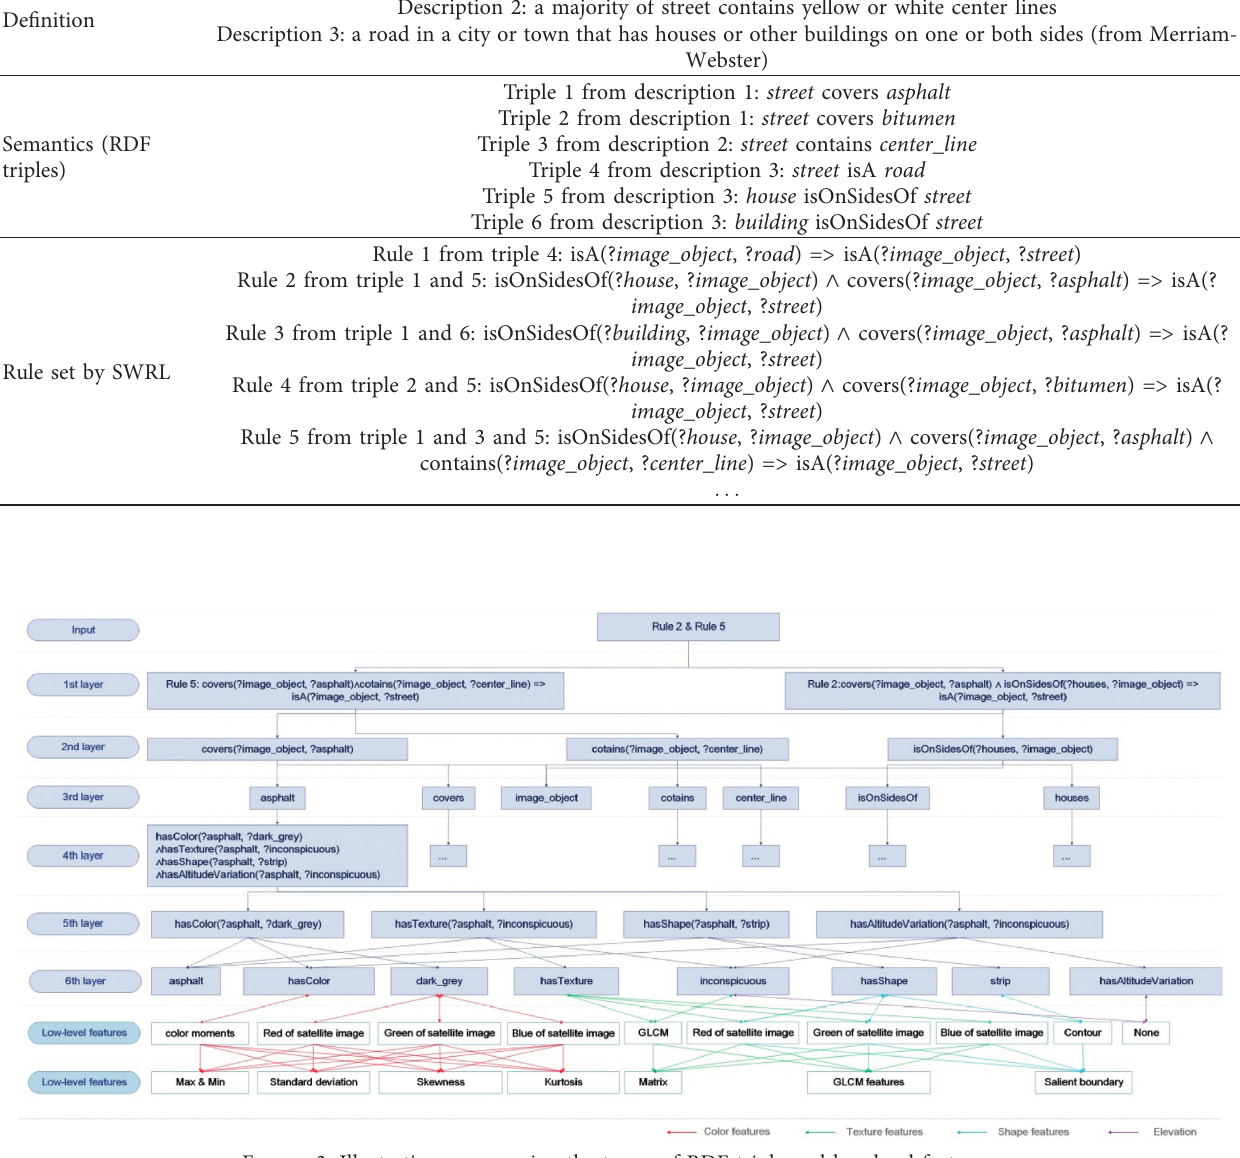
Figure 3: Illustration on mapping the terms of RDF triple and low-level features.